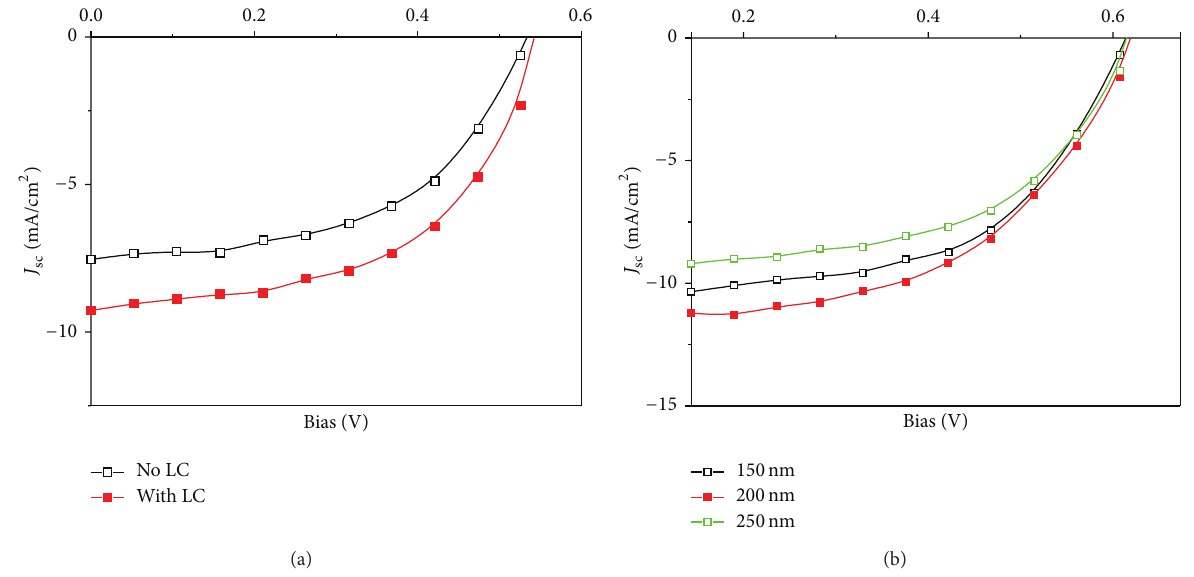
Figure 4: J - V curves for the semitransparent PSCs (a) with and without the LC reflector. The active layer thicknesses were both 100nm. (b) J - V curves for the semitransparent PSCs with the LC reflector. The thicknesses for active layers A, B, and C were 150nm, 200 nm, and 250 nm, respectively.